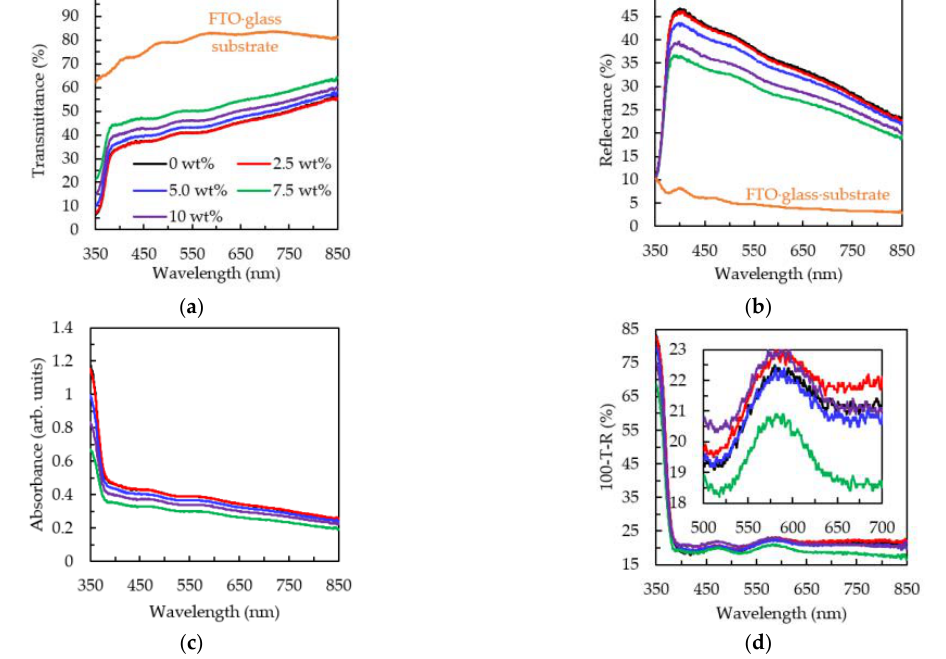
Figure 3. The ( a ) transmittance (T), ( b ) reflectance (R), ( c ) absorbance, and ( d ) haze spectra for the TiO 2 films prepared by injecting different DMF doses from 0 to 10 wt%, where the inserted haze image is in the range from 500 to 700 nm.